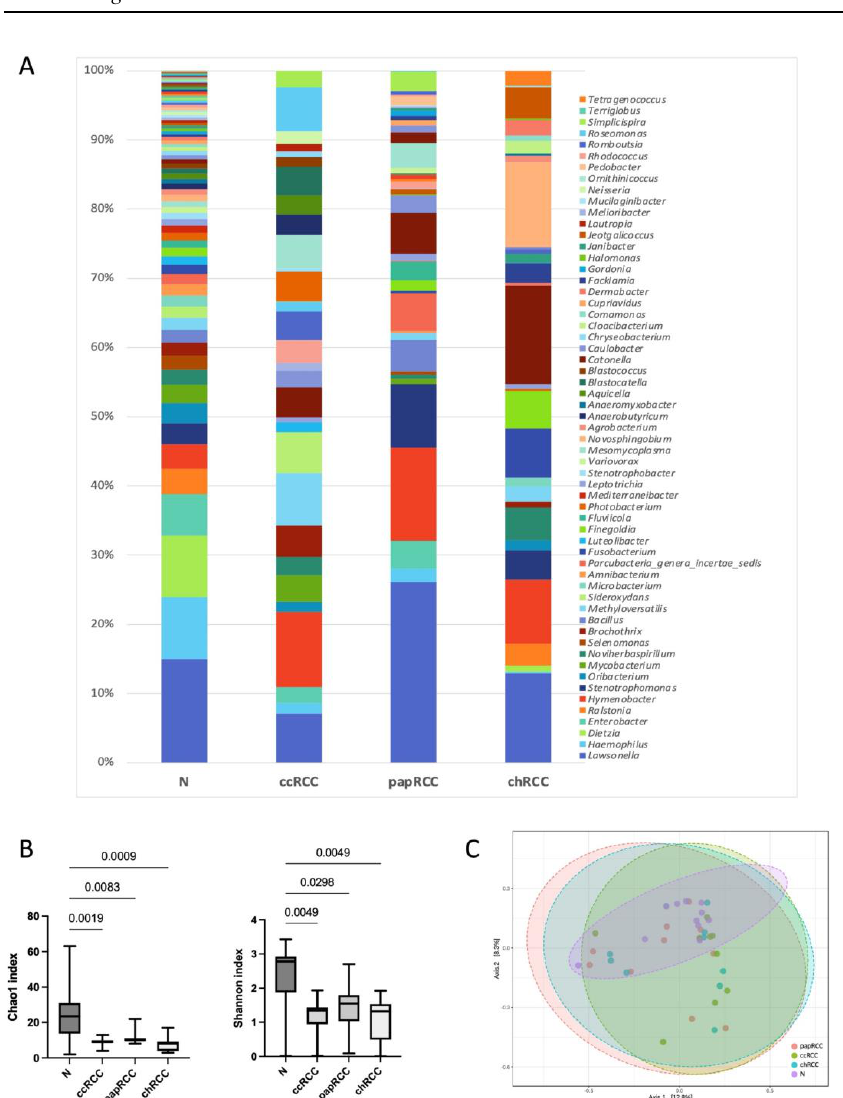
Figure 2. Taxonomic composition of the microbial community of renal tissues on the level of genus. ( A ) Characterization of renal cell cancer (RCC) microbiota. Colored lines represent relative abundance at the genus level for tumor (ccRCC, papRCC, chRCC) and normal tissue (N) samples. ( B ) Taxonomic α -diversity calculated with Shannon and Chao1 indices between N and tumor groups. p -values are indicated above the lines. ( C ) PCoA plot based on Bray–Curtis distance of renal microbiome between tumor and normal tissues (PERMANOVA). F-value: 1.1096; R-squared: 0.082541; p -value < 0.226.